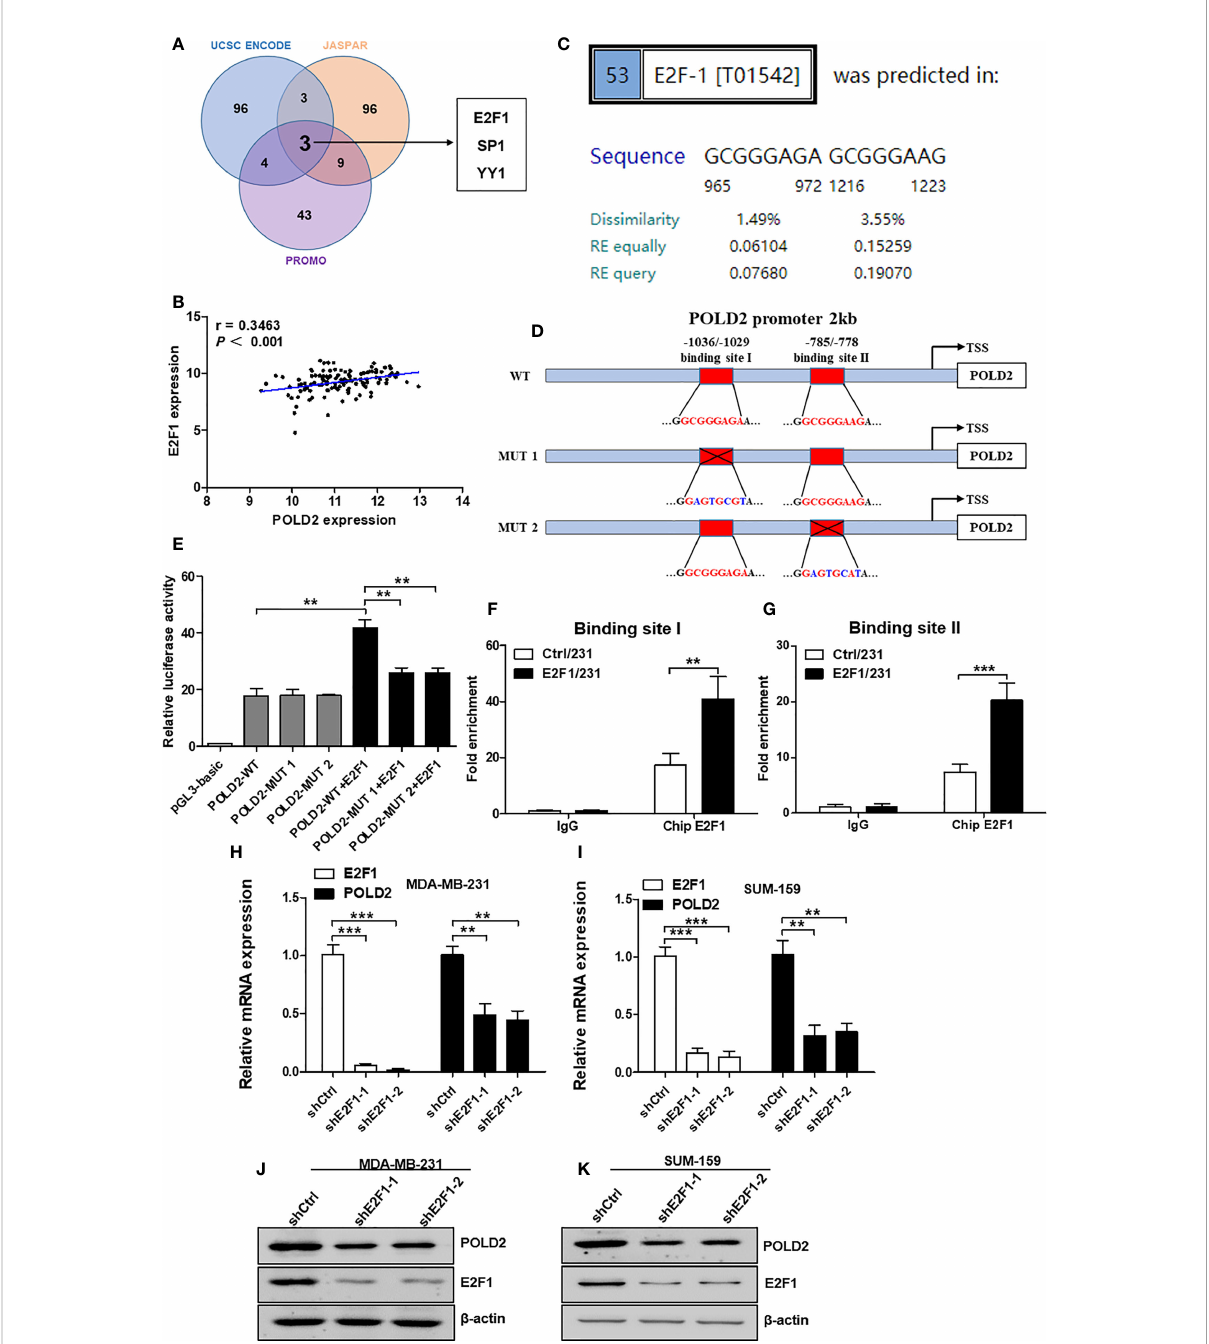
FIGURE 3 E2F1 transcriptionally regulates POLD2 expression in TNBC cells. (A) Three websites, UCSC ENCODE, JASPAR, and PROMO, were employed to predict the potential TFs. Three TFs were possible candidates. (B) A correlation between POLD2 expression and E2F1 expression in TNBC samples was analyzed by TCGA databases. (C) The binding sites of E2F1 within the promoter region of the POLD2 gene (~2 kb) were predicted by using the PROMO platform. (D) The diagram showed the putative E2F1 binding sites (EBSs) located in the promoter region of the POLD2 gene. Luciferase reporter vectors containing WT-POLD2-promoter or MUT-POLD2-promoter were constructed. (E) Luciferase reporter assays showed that POLD2 promoter enhanced luciferase activities in E2F1-expressing MDA-MB-231 cells, whereas those carrying mutant sites showed strong repression of luciferase activities. ** P < 0.01. (F, G) Overexpression of E2F1 signi fi cantly enhanced its recruitment to the endogenous POLD2 promoter as con fi rmed by a ChIP-qPCR assay. *** P < 0.001, ** P < 0.01. (H – K) The mRNA (H, I) and protein (J, K) expression of E2F1 and POLD2 in shCtrl/231, shE2F1/231, shCtrl/159 and shE2F1/159cells. *** P < 0.001, ** P < 0.01. Data represent the mean ± SD of three independent